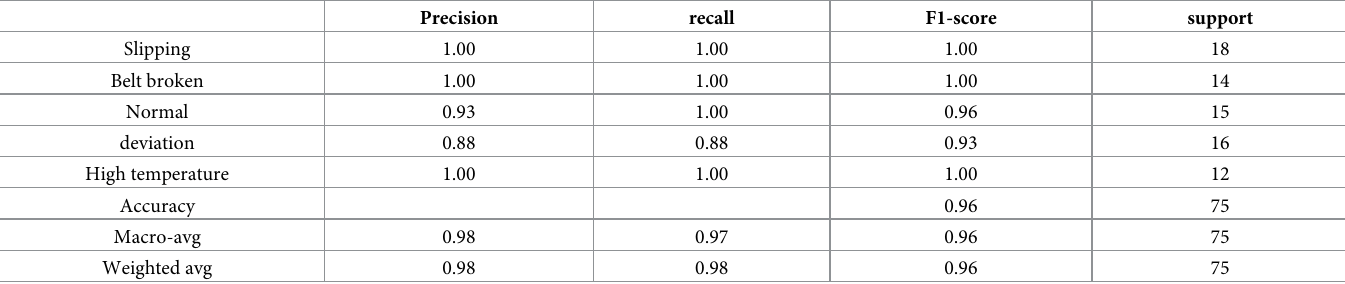
Table 4. Evaluation index